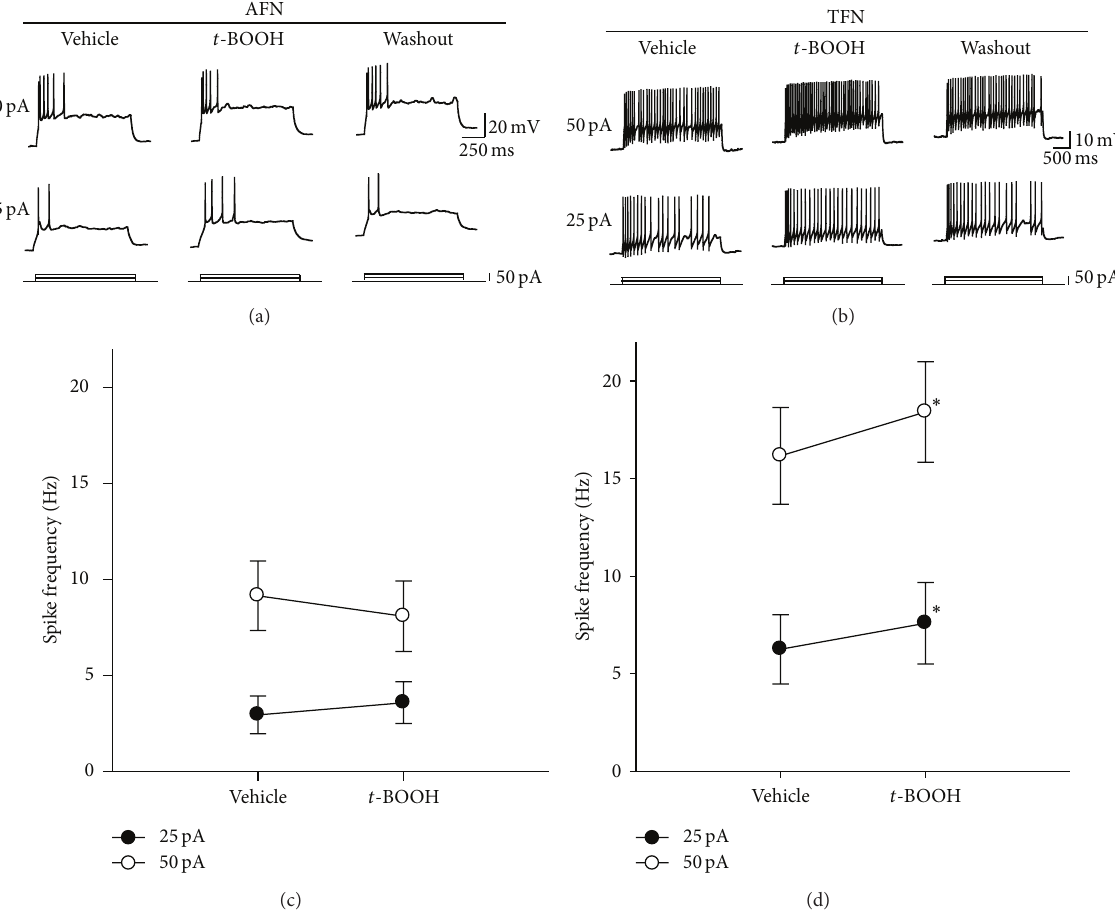
Figure 4: Effects of t -BOOH on the excitability of SG neurons in spinal cord slices. (a) Recordings of action potentials generated in an AFN. Actionpotentialswereevokedbydirectintracellularinjectionsofcurrentpulses(25or50 pA).(b)Changesinthefrequencyofactionpotential in a TFN. After t -BOOH treatment, the frequency of action potentials increased, compared to that observed with the vehicle treatment. (c) Average action potential firing rate measured by step current pulses after t -BOOH treatment in AFNs ( 𝑛 = 14 ). The data are mean with standarderrorsofthemean.(d)Averageactionpotentialfiringratemeasuredbystepcurrentpulsesafter t -BOOHtreatmentinTFNs( 𝑛 = 12 ). Asterisks indicate values that are significantly different from those for the vehicle control as determined by a paired t -test ( 𝑃 < 0.05